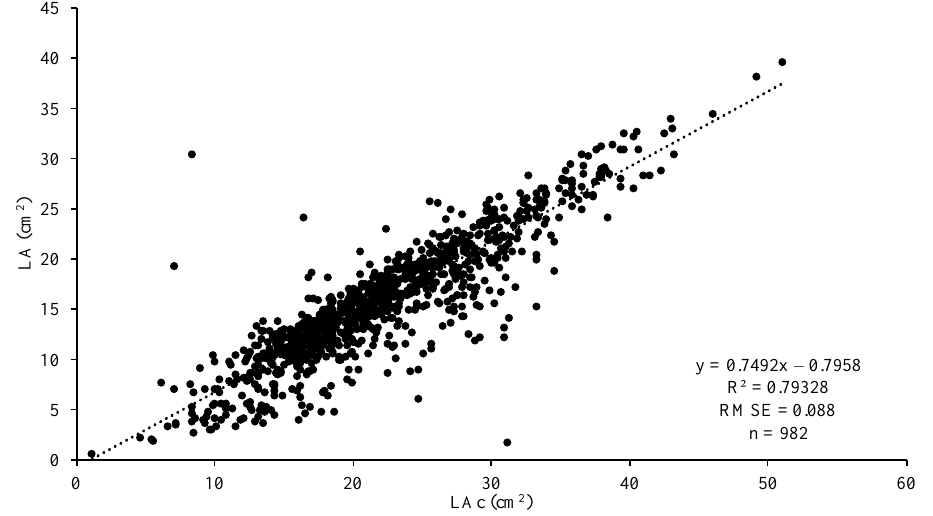
Figure 1. Regression between calculated leaf area (by assessing leaf length × leaf width; LAc) and scanned leaf area (by using the leaf area meter LI-COR, Model LI-3000A; LA) of tangolagrass.